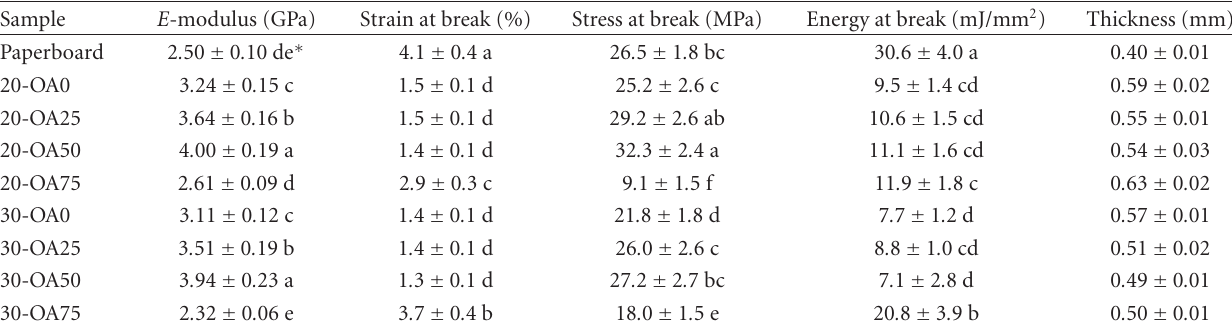
Table 2: Mechanical properties of the uncoated and laminated